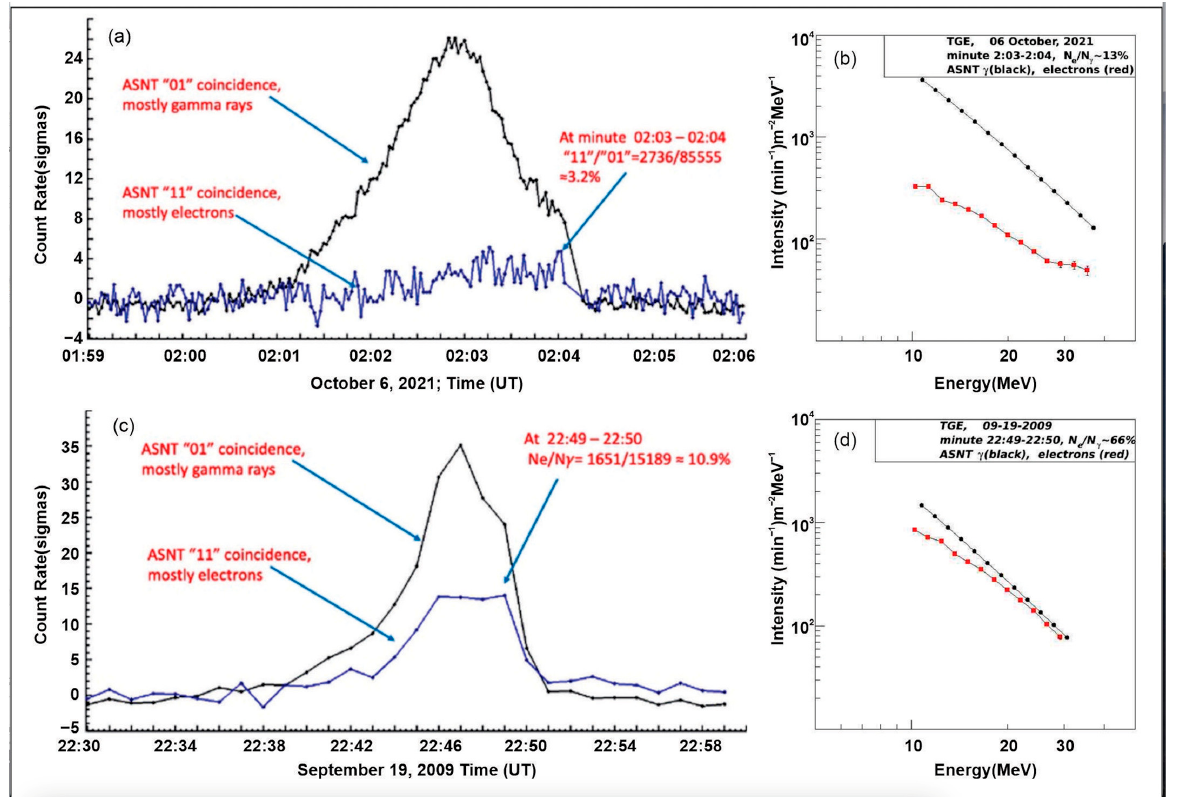
Figure 4. ( a ) 2 s time series of the count rate coincidences measured using the ASNT spectrometer, shown in the number of standard deviations (N σ ) from the mean value measured in fairweather before the TGE; ( b ) differential energy spectra recovered from the energy release histograms; ( c ) 1 min time series of the coincidence count rates measured using the ASNT spectrometer; ( d ) differential energy spectra recovered from energy release histograms. ©PRD. Reproduced with permission. On the contrary, as seen in Figure 4d, the intensities of the electron and gamma rays are almost equal for the TGE measured on 19 September 2009. The ratio of electrons to gamma rays reaches 66% at minutes 22:49–22:50. This can only occur if the strong acceler- ating electric field is very low above the ground (we estimate a height of 25–50 m). The electron avalanche covers a significant area on the ground. Additional evidence of elec- tron flux registration on 19 September 2009 is shown in Figure 5.